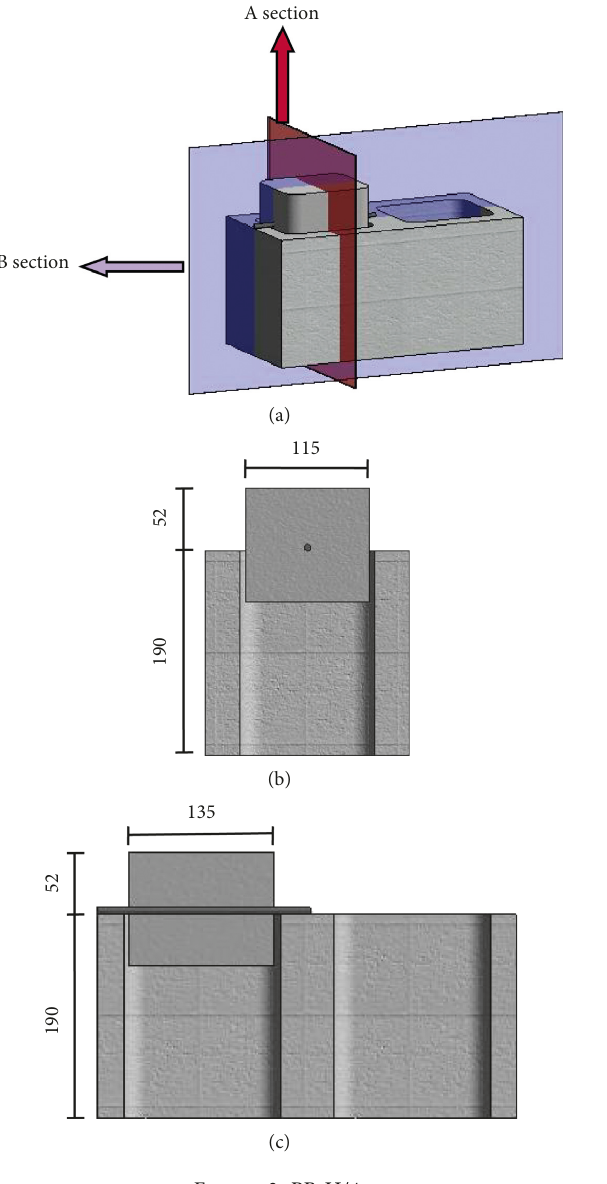
Figure 3: PB-H/4.